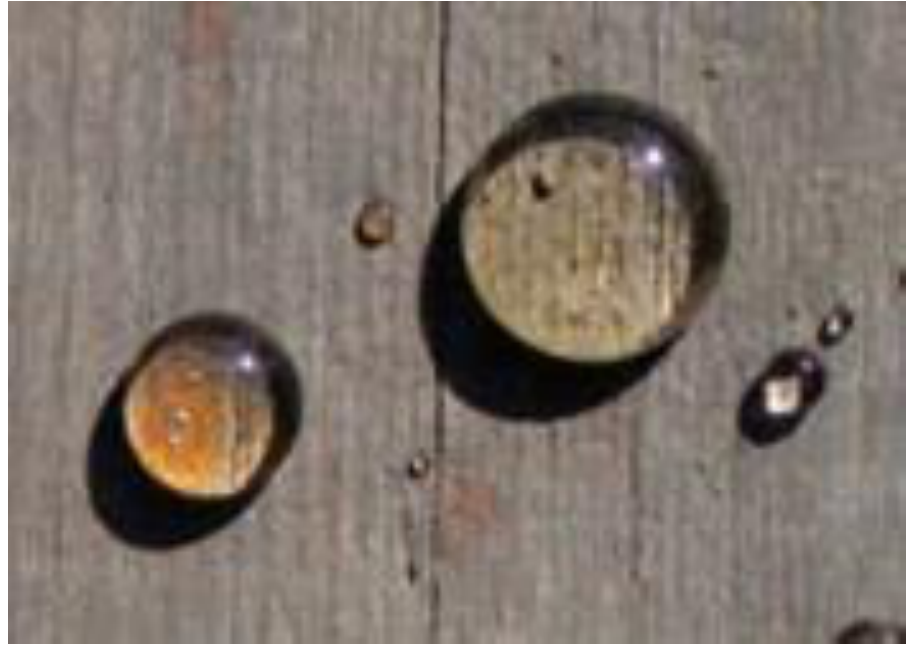
Figure 19. Water droplets on wood with a nanozincoxide coating.